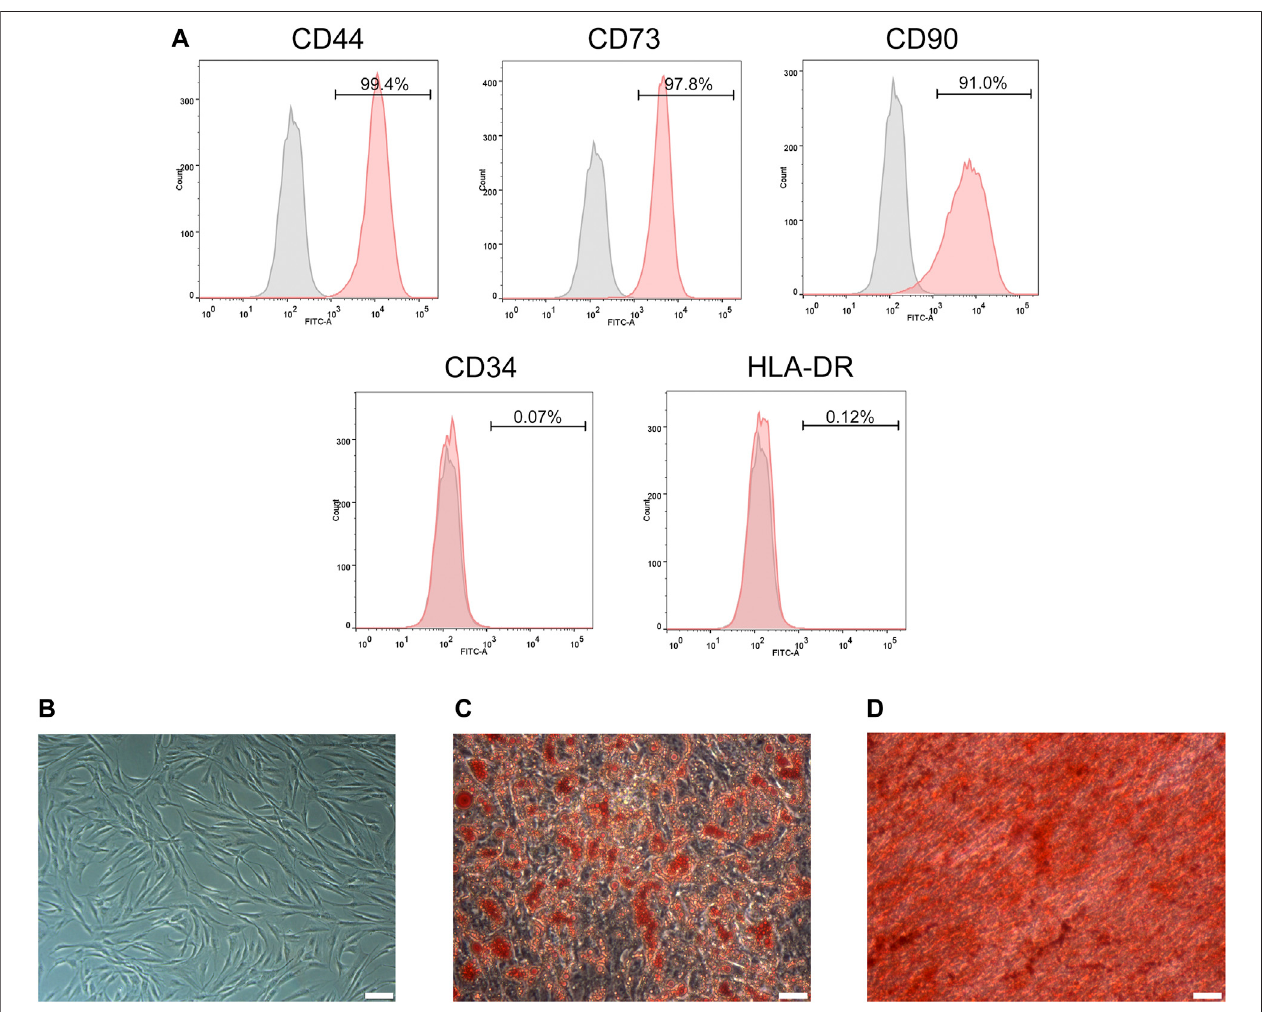
FIGURE1| Identi fi cationofADSCs. (A) FlowcytometryanalysisshowedthatADSCswerepositiveforCD44,CD73andCD90butnegativeforCD34andHLA-DR. (B) The morphology of ADSCs. (C) Adipogenic potentials of ADSCs (oil red O staining). (D) Osteogenic potentials of ADSCs (alizarin red staining). (A,C,D) Scale bars: 100